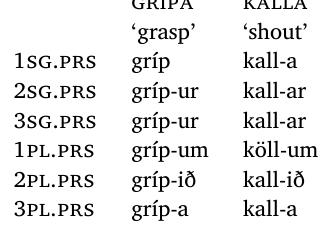
Indicative present forms of two Icelandic verb classes. Some allomorphs are the same in both